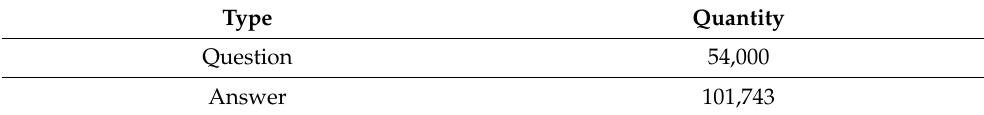
Table 5. Q&A dataset statistics.